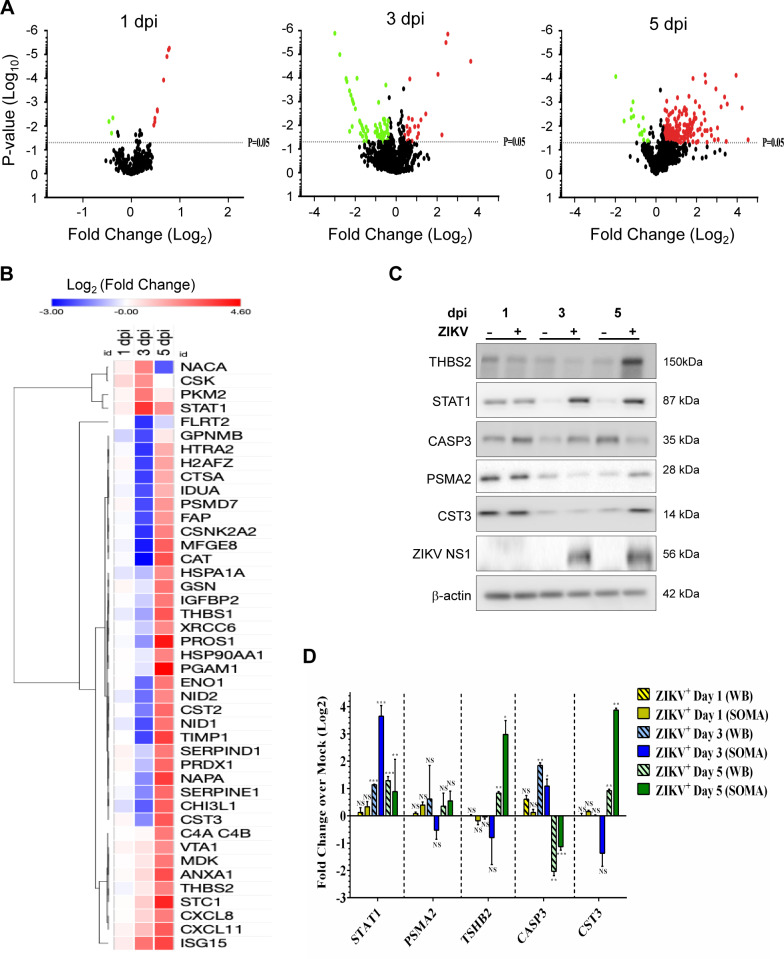
Proteomic analyses of ZIKV-infected HSerC by SOMAscan.(A) Volcano plots showing the expression fold changes and the significance of differentially expressed proteins at 1, 3 and 5 dpi (P-value < 0.05). Up- and down-regulated proteins are highlighted in red and green, respectively. (B) Heat map of selected differentially expressed (fold change > 4 or < -4) proteins at 1, 3 and 5 days post ZIKV infection. Up- and down-regulated proteins are highlighted in red and blue, respectively. (C) Validation of SOMAscan results by Western blot of 5 selected differentially regulated proteins. (D) Expression value of the proteins from Western-blot were quantified from three replicates and plotted side-by-side to SOMAscan expression values. In both techniques, expression value of each protein in infected cells was compared with time-matched mock for quantifying significant dysregulation. *** = P-value <0.001, ** = P-value < 0.01, * = P-value < 0.05. dpi = days post-infection.